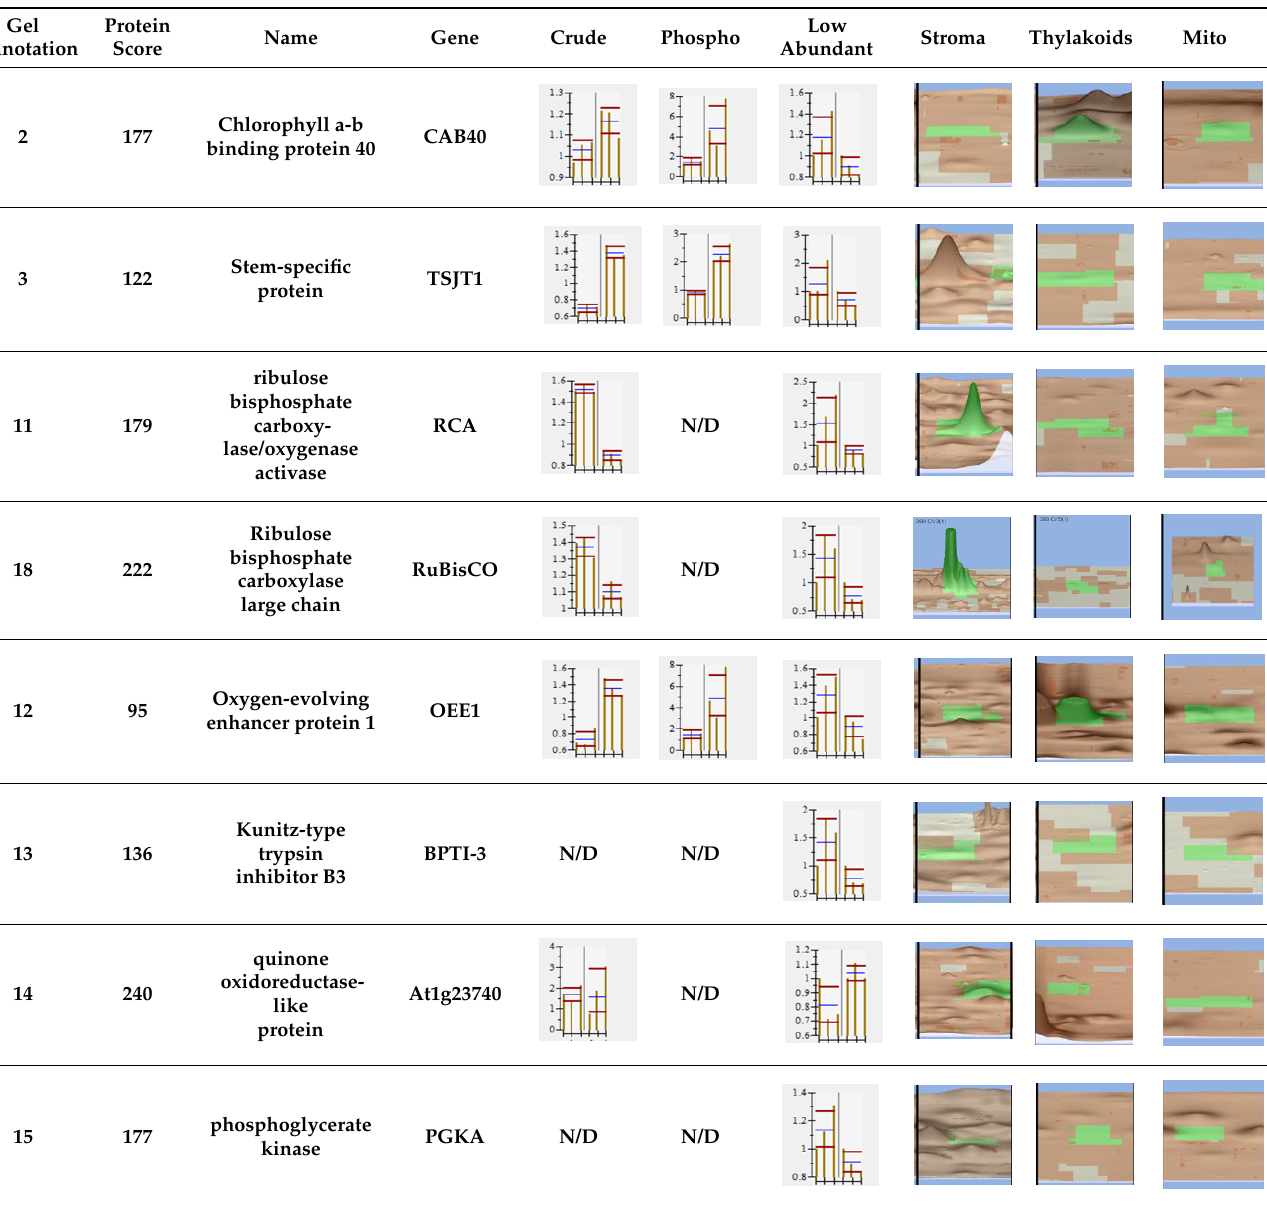
(spot 26). Several proteins linked to carbon fixation and photosynthesis were detected in different fractions. RuBisCO activase and RbcL (spots 11 and 18, respectively) decreased in desiccated plants. Chlorophyll a-b binding protein 40 (spot 2) was overexpressed, ex- hibiting increased phosphorylation in the phosphoproteome. The level of oxygen-evolving Table 1. Expression, phosphorylation, and localization of identified proteins from different fractions. Each identified Table 1. Expression, phosphorylation, and localization of identified proteins from different fractions. Each identified Table 1. Expression, phosphorylation, and localization of identified proteins from different fractions. Each identified Table 1. Expression, phosphorylation, and localization of identified proteins from different fractions. Each identified Table 1. Expression, phosphorylation, and localization of identified proteins from different fractions. Each identified enhancer protein 1 (OEE1) increased in the dried leaves’ total proteome and phospho- proteome (spot 12). Among the stress-responsive proteins, a drought-induced increase protein is annotated in the gels in Figure 2 with its corresponding spot number. The histograms for each spot protein is annotated in the gels in Figure 2 with its corresponding spot number. The histograms for each spot protein is annotated in the gels in Figure 2 with its corresponding spot number. The histograms for each spot protein is annotated in the gels in Figure 2 with its corresponding spot number. The histograms for each spot protein is annotated in the gels in Figure 2 with its corresponding spot number. The histograms for each spot Table 1. Expression, phosphorylation, and localization of identified proteins from different fractions. Each identified Table 1. Expression, phosphorylation, and localization of identified proteins from different fractions. Each identified Table 1. Expression, phosphorylation, and localization of identified proteins from different fractions. Each identified Table 1. Expression, phosphorylation, and localization of identified proteins from different fractions. Each identified Table 1. Expression, phosphorylation, and localization of identified proteins from different fractions. Each identified in phosphorylated dehydrin (pI 5.9, MW 20 kDa; spot 20) was detected in the thylakoid display differences in spot volume between the fresh (left) and dry (right) samples ( n = 3). Three-dimensional Table 1. Expression, phosphorylation, and localization of identified proteins from different fractions. Each identified display differences in spot volume between the fresh (left) and dry (right) samples ( n = 3). Three-dimensional display differences in spot volume between the fresh (left) and dry (right) samples ( n = 3). Three-dimensional display differences in spot volume between the fresh (left) and dry (right) samples ( n = 3). Three-dimensional protein is annotated in the gels in Figure 2 with its corresponding spot number. The histograms for each spot display differences in spot volume between the fresh (left) and dry (right) samples ( n = 3). Three-dimensional Table 1. Expression, phosphorylation, and localization of identified proteins from different fractions. Each identified Table 1. Expression, phosphorylation, and localization of identified proteins from different fractions. Each identified protein is annotated in the gels in Figure 2 with its corresponding spot number. The histograms for each spot Table 1. Expression, phosphorylation, and localization of identified proteins from different fractions. Each identified Table 1. Expression, phosphorylation, and localization of identified proteins from different fractions. Each identified Table 1. Expression, phosphorylation, and localization of identified proteins from different fractions. Each identified protein is annotated in the gels in Figure 2 with its corresponding spot number. The histograms for each spot protein is annotated in the gels in Figure 2 with its corresponding spot number. The histograms for each spot protein is annotated in the gels in Figure 2 with its corresponding spot number. The histograms for each spot fraction. Several proteins could not be annotated using the databases employed in this Table 1. Expression, phosphorylation, and localization of identified proteins from different fractions. Each identified Table 1. Expression, phosphorylation, and localization of identified proteins from different fractions. Each identified Table 1. Expression, phosphorylation, and localization of identified proteins from different fractions. Each identified Table 1. Expression, phosphorylation, and localization of identified proteins from different fractions. Each identified Table 1. Expression, phosphorylation, and localization of identified proteins from different fractions. Each identified Table 1. Expression, phosphorylation, and localization of identified proteins from different fractions. Each identified (3D) spot reports show the volume of each matched spot (green) in its corresponding organelle fraction. protein is annotated in the gels in Figure 2 with its corresponding spot number. The histograms for each spot (3D) spot reports show the volume of each matched spot (green) in its corresponding organelle fraction. (3D) spot reports show the volume of each matched spot (green) in its corresponding organelle fraction. (3D) spot reports show the volume of each matched spot (green) in its corresponding organelle fraction. display differences in spot volume between the fresh (left) and dry (right) samples ( n = 3). Three-dimensional (3D) spot reports show the volume of each matched spot (green) in its corresponding organelle fraction. protein is annotated in the gels in Figure 2 with its corresponding spot number. The histograms for each spot protein is annotated in the gels in Figure 2 with its corresponding spot number. The histograms for each spot protein is annotated in the gels in Figure 2 with its corresponding spot number. The histograms for each spot display differences in spot volume between the fresh (left) and dry (right) samples ( n = 3). Three-dimensional protein is annotated in the gels in Figure 2 with its corresponding spot number. The histograms for each spot protein is annotated in the gels in Figure 2 with its corresponding spot number. The histograms for each spot display differences in spot volume between the fresh (left) and dry (right) samples ( n = 3). Three-dimensional display differences in spot volume between the fresh (left) and dry (right) samples ( n = 3). Three-dimensional display differences in spot volume between the fresh (left) and dry (right) samples ( n = 3). Three-dimensional study, indicating a potential for further research. protein is annotated in the gels in Figure 2 with its corresponding spot number. The histograms for each spot protein is annotated in the gels in Figure 2 with its corresponding spot number. The histograms for each spot protein is annotated in the gels in Figure 2 with its corresponding spot number. The histograms for each spot protein is annotated in the gels in Figure 2 with its corresponding spot number. The histograms for each spot protein is annotated in the gels in Figure 2 with its corresponding spot number. The histograms for each spot protein is annotated in the gels in Figure 2 with its corresponding spot number. The histograms for each spot display differences in spot volume between the fresh (left) and dry (right) samples ( n = 3). Three-dimensional (3D) spot reports show the volume of each matched spot (green) in its corresponding organelle fraction. display differences in spot volume between the fresh (left) and dry (right) samples ( n = 3). Three-dimensional display differences in spot volume between the fresh (left) and dry (right) samples ( n = 3). Three-dimensional display differences in spot volume between the fresh (left) and dry (right) samples ( n = 3). Three-dimensional (3D) spot reports show the volume of each matched spot (green) in its corresponding organelle fraction. display differences in spot volume between the fresh (left) and dry (right) samples ( n = 3). Three-dimensional display differences in spot volume between the fresh (left) and dry (right) samples ( n = 3). Three-dimensional (3D) spot reports show the volume of each matched spot (green) in its corresponding organelle fraction. (3D) spot reports show the volume of each matched spot (green) in its corresponding organelle fraction. (3D) spot reports show the volume of each matched spot (green) in its corresponding organelle fraction. Gel Gel display differences in spot volume between the fresh (left) and dry (right) samples ( n = 3). Three-dimensional display differences in spot volume between the fresh (left) and dry (right) samples ( n = 3). Three-dimensional display differences in spot volume between the fresh (left) and dry (right) samples ( n = 3). Three-dimensional display differences in spot volume between the fresh (left) and dry (right) samples ( n = 3). Three-dimensional display differences in spot volume between the fresh (left) and dry (right) samples ( n = 3). Three-dimensional display differences in spot volume between the fresh (left) and dry (right) samples ( n = 3). Three-dimensional Table 1. Expression, phosphorylation, and localization of identified proteins from different fractions. (3D) spot reports show the volume of each matched spot (green) in its corresponding organelle fraction. (3D) spot reports show the volume of each matched spot (green) in its corresponding organelle fraction. (3D) spot reports show the volume of each matched spot (green) in its corresponding organelle fraction. (3D) spot reports show the volume of each matched spot (green) in its corresponding organelle fraction. (3D) spot reports show the volume of each matched spot (green) in its corresponding organelle fraction. (3D) spot reports show the volume of each matched spot (green) in its corresponding organelle fraction. Each identified protein is annotated in the gels in Figure 2 with its corresponding spot number. The (3D) spot reports show the volume of each matched spot (green) in its corresponding organelle fraction. (3D) spot reports show the volume of each matched spot (green) in its corresponding organelle fraction. (3D) spot reports show the volume of each matched spot (green) in its corresponding organelle fraction. (3D) spot reports show the volume of each matched spot (green) in its corresponding organelle fraction. (3D) spot reports show the volume of each matched spot (green) in its corresponding organelle fraction. (3D) spot reports show the volume of each matched spot (green) in its corresponding organelle fraction. histograms for each spot display differences in spot volume between the fresh (left) and dry (right) samples ( n = 3). Three-dimensional (3D) spot reports show the volume of each matched spot (green) Low in its corresponding organelle fraction. Gene Crude Phospho Abundan